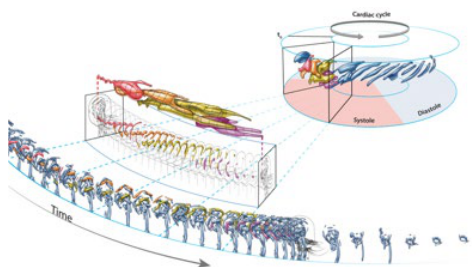
Figure 3 | Final artistic prototype of the carousel: All three rings depict the same flow pattern evolution over a cardiac cycle. For easier access of information regarding either a particular structure of the turbulent-like flow, as it changes during that period of time, or follow the multitude of these structures emphasizing the critical ones, colours having been chosen in order to discriminate the evolution of selected repeating vortex structures, highlighting their potential contribution to the risk of growth or rupture of the aneurysm. Outer ring shows hand-rendered vortex structures evolving through time; middle ring isolates selected vortices, caricatured to highlight repeating structures; inner carousel shows full cardiac